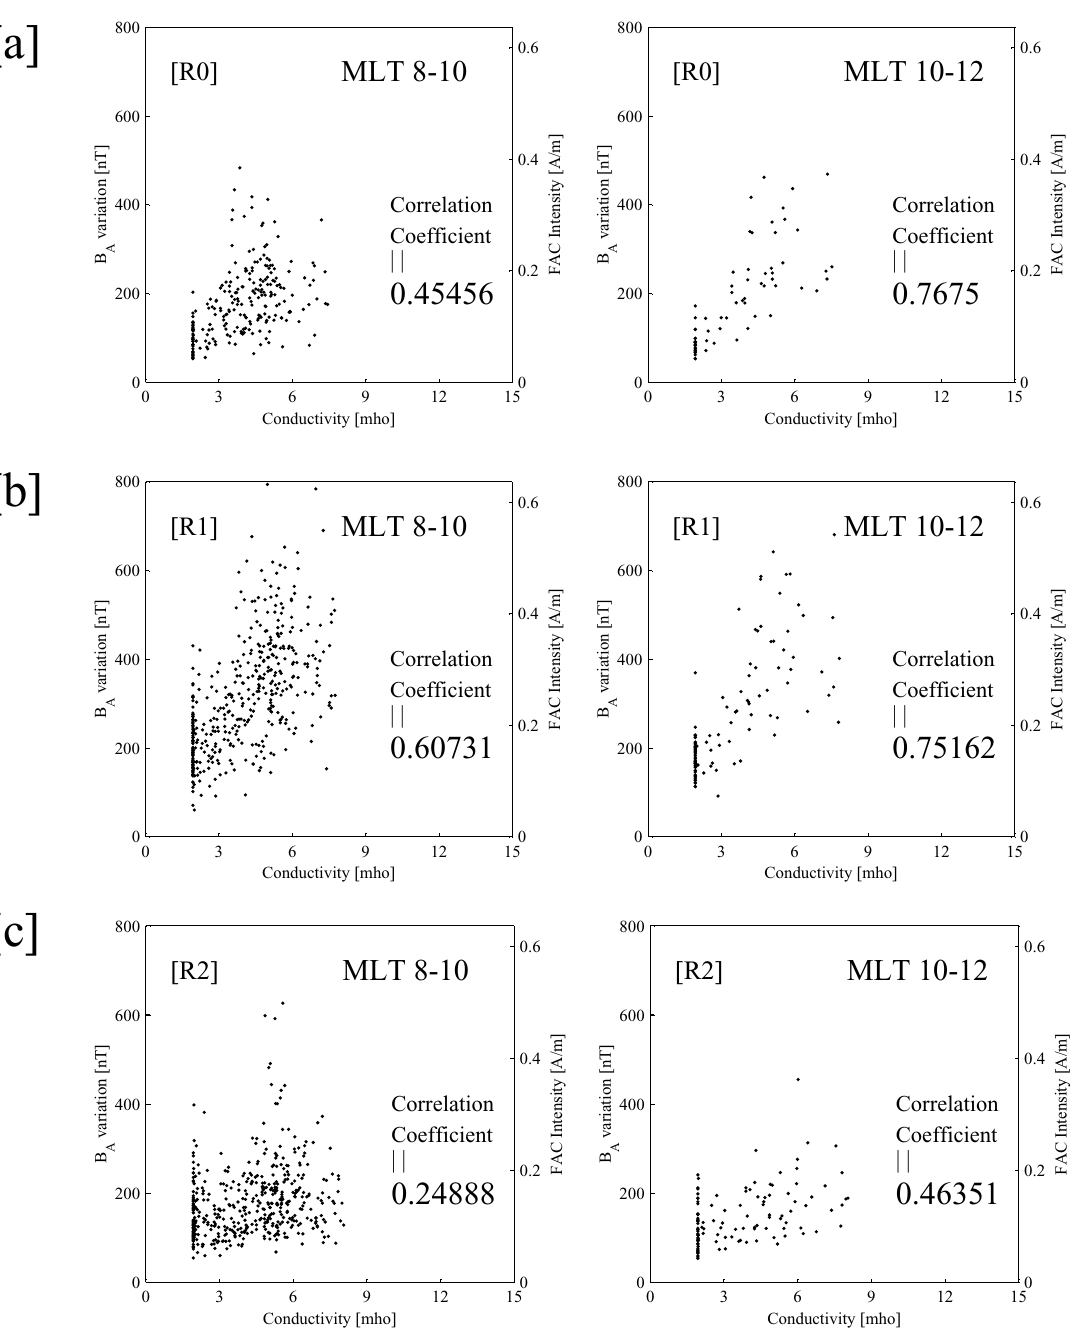
Figure 4 Fig. 4. Scatter plots of the B A displacement versus the ionospheric conductivity in each two-hour MLT bin from 08:00–12:00 MLT. The top (middle, bottom) panel shows the plot for the data of R0 (R1, R2). coefficients from Mehta’s formula and the vertical line segments show the error bars. The correlation coefficient of R1 is significantly larger than that of R2 in both MLT sectors. For R0, the correlation coefficient is larger than that of R2 in both MLT and similar to that of R1 in 10:00–12:00